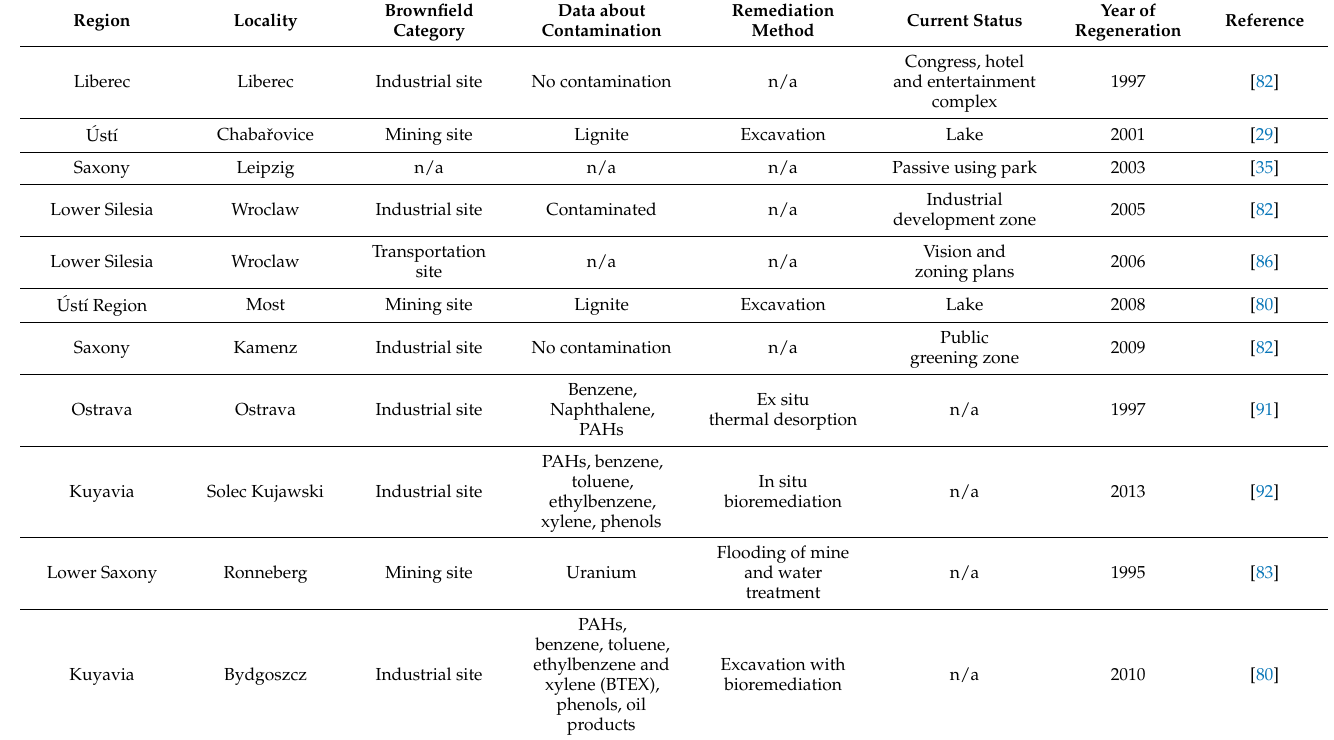
Table 6. Local case studies on brownfield regeneration in the targeted regions of the Northern Czech Republic, Germany and Poland and nearby